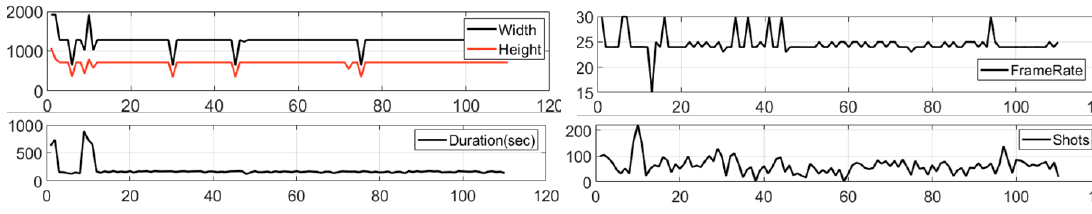
Figure 15. Information on the size, frame rate, duration, and detected shots in our test dataset.